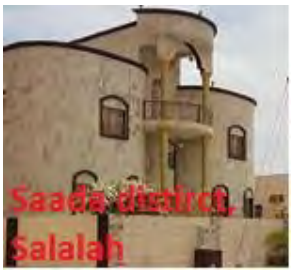
Figure 14. Fac¸ade’s photograph building location